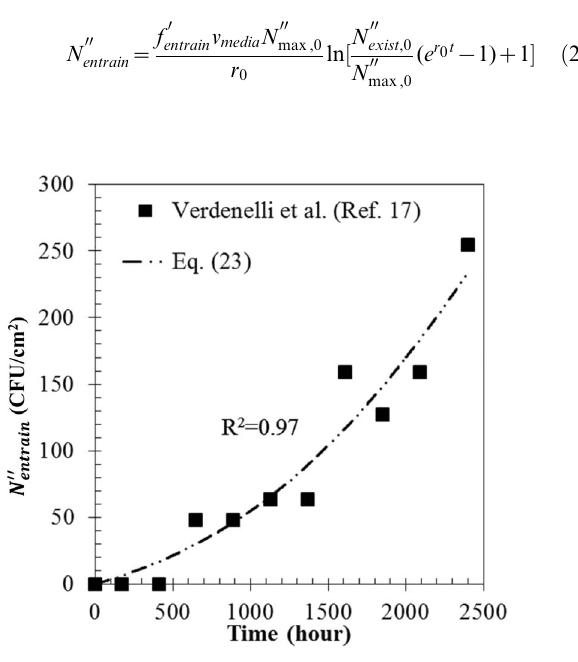
Figure 1. Determination of the growth rate and entrainment constant. Comparison of the calculation results (line) and the experimental finding (solid square).